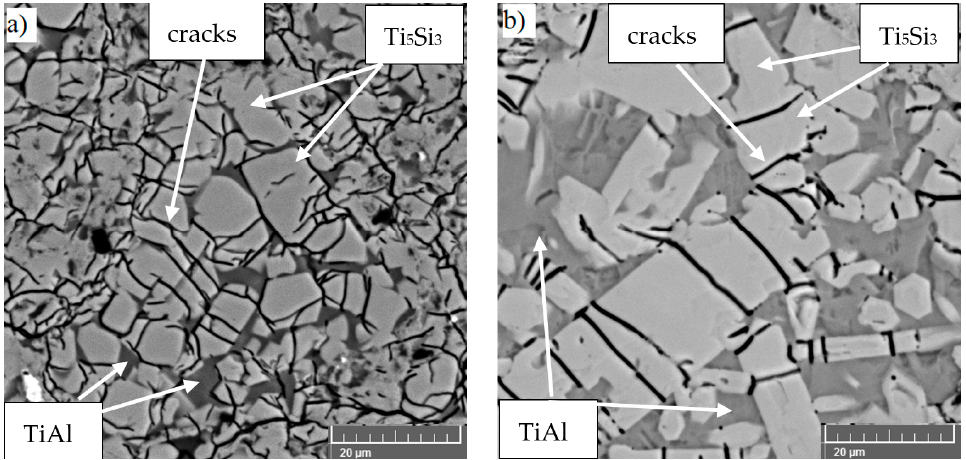
Figure 7. TiAl10Si20 alloy prepared by HP SPS: ( a ) 6 GPa, 907 °C, 150 s, ( b ) 6 GPa, 1324 °C, 30 s.